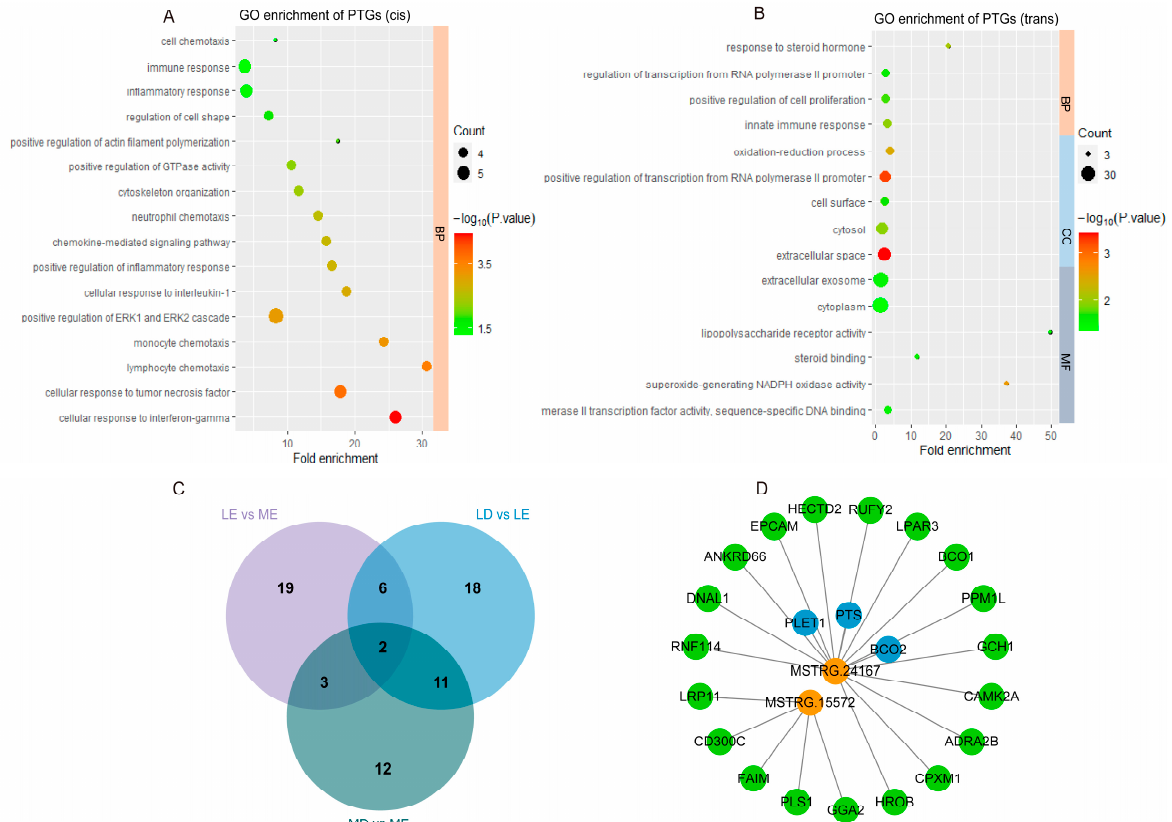
Figure 3. Function analysis and identification of key lincRNAs. ( A ) GO enrichment analysis of PTGs by cis-acting of DELs. ( B ) GO enrichment analysis of PTGs by trans-acting of DELs. ( C ) DELs distribution in the LE vs. ME, LD vs. LE, and MD vs. ME comparisons. ( D ) Co-expression network of the 2 key lincRNAs and their PTGs; the blue represents PTGs by cis-acting, and the green represents PTGs by trans-acting.